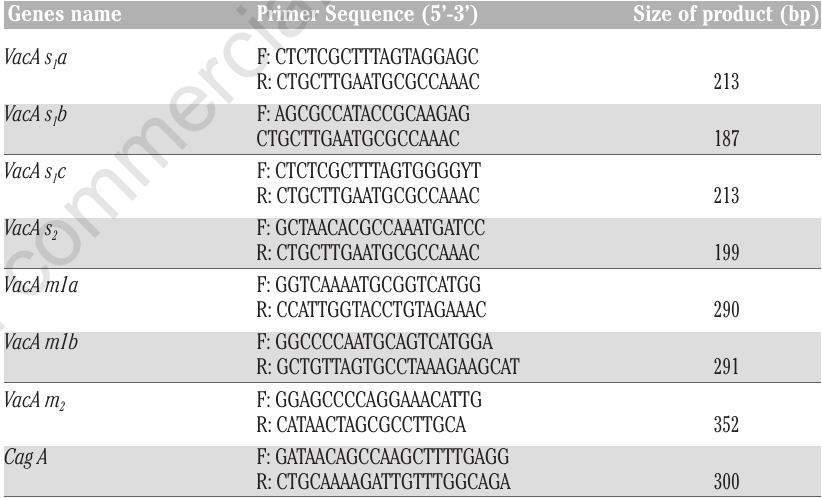
Table 1. List of primers used for genotyping of Helicobacter pylori strains detected in fecal samples of dogs.